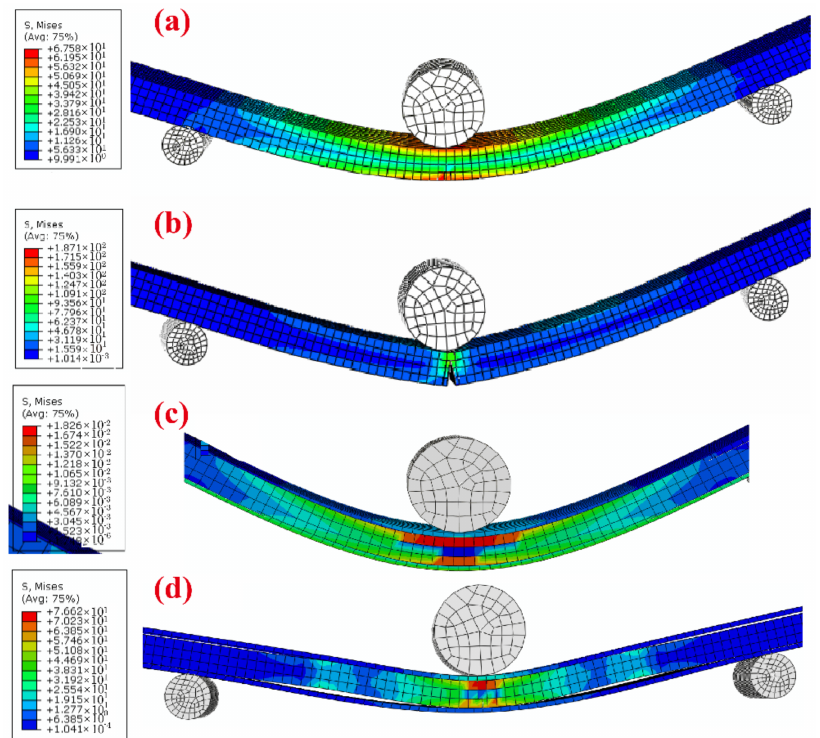
Figure 10. Schematic graph of the flexural samples for finite element modeling. Single-layer wood flour/HDPE composites ( a , b ), multilayered wood flour/HDPE/PC composites ( c , d